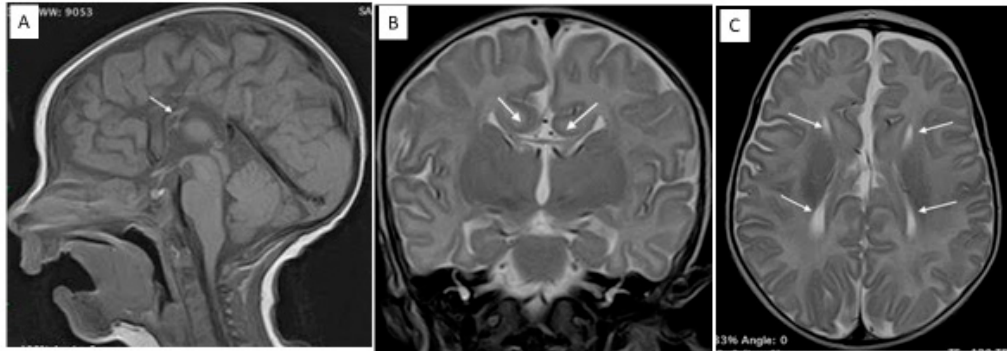
Figure 1. RJ’s magnetic resonance imaging. ( A ) Sagittal T1 WI. The corpus callosum is absent. There is a small residual portion (arrow) in the genu / anterior body. ( B ) Coronal turbo T2 WI. The cingulate gyri are everted as a result of the absence of the callosal fibers (arrows). There is a small residual portion of the genu / anterior body (thin arrows). ( C ) Axial turbo T2 WI. The walls of the lateral ventricles are dysmorphic because the Probst bundles do not cross the midline.